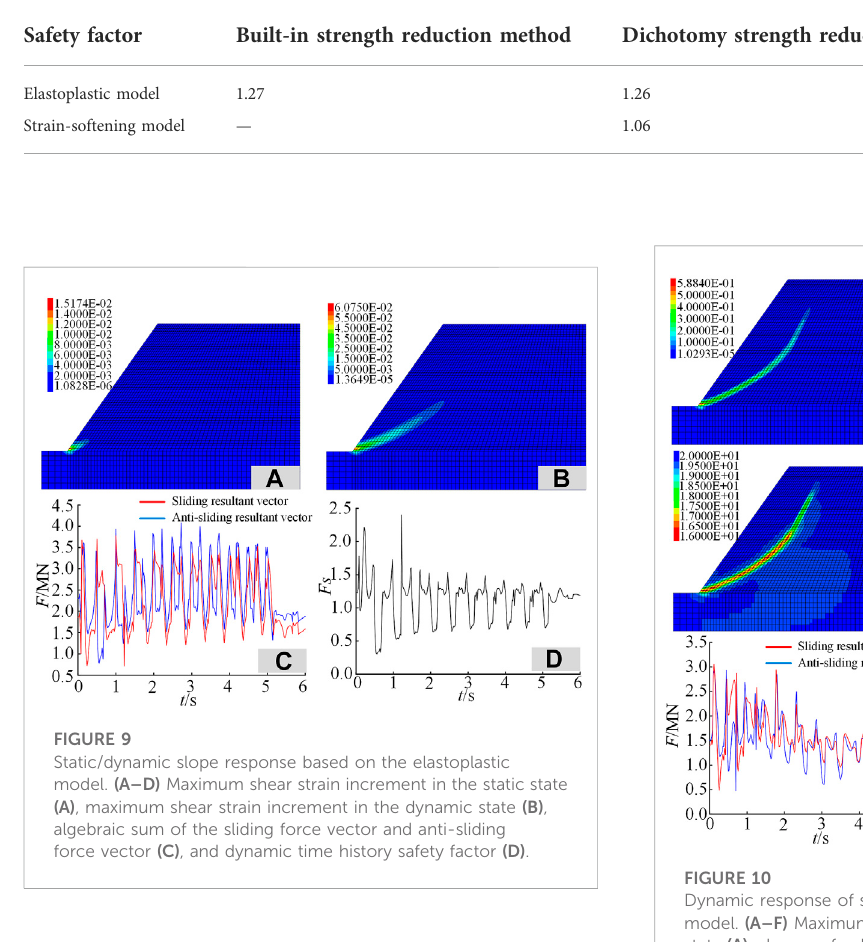
TABLE 2 Safety factors calculated by different methods.